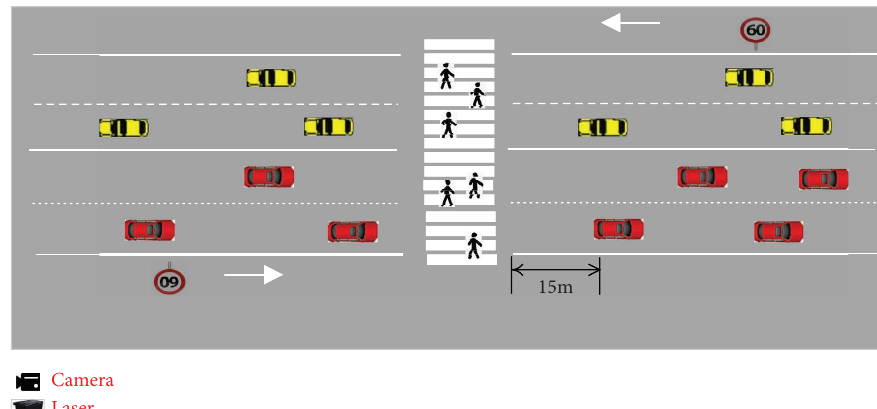
Figure 4: Schematic diagram of the study site: the equipment is placed at the curb, about 15 meters away from the zebra crossing.